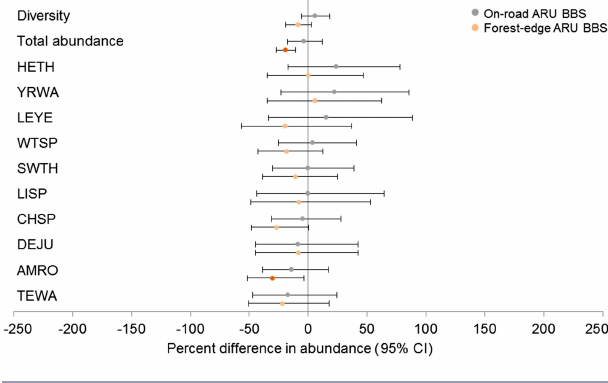
Fig. 2 . Percent difference (95% confidence interval [CI]) in relative abundance in counts from (1) human North American Breeding Bird Survey (BBS) and on-road autonomous recording unit (ARU) BBS surveys and (2) human BBS and forest-edge ARU BBS surveys. This metric is considered a measure of bias in detection, where values lower than 0 indicate higher counts in human BBS surveys, whereas values higher than 0 indicate higher counts for the other treatment of interest. Darker colors represent statistically significant differences between treatments. See Results for definitions of abbreviations.